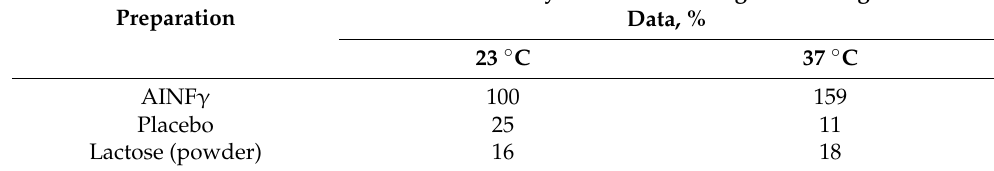
Table 4. The specificity of activation of thermal radio emission using the example of